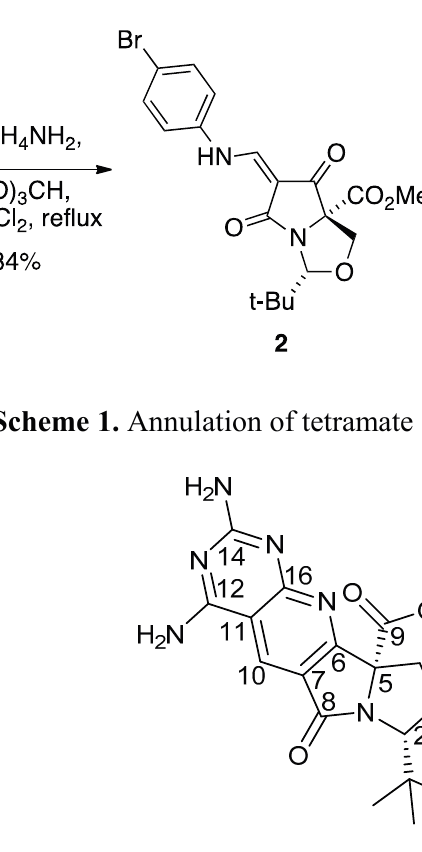
Figure 1. Structure of compound 4